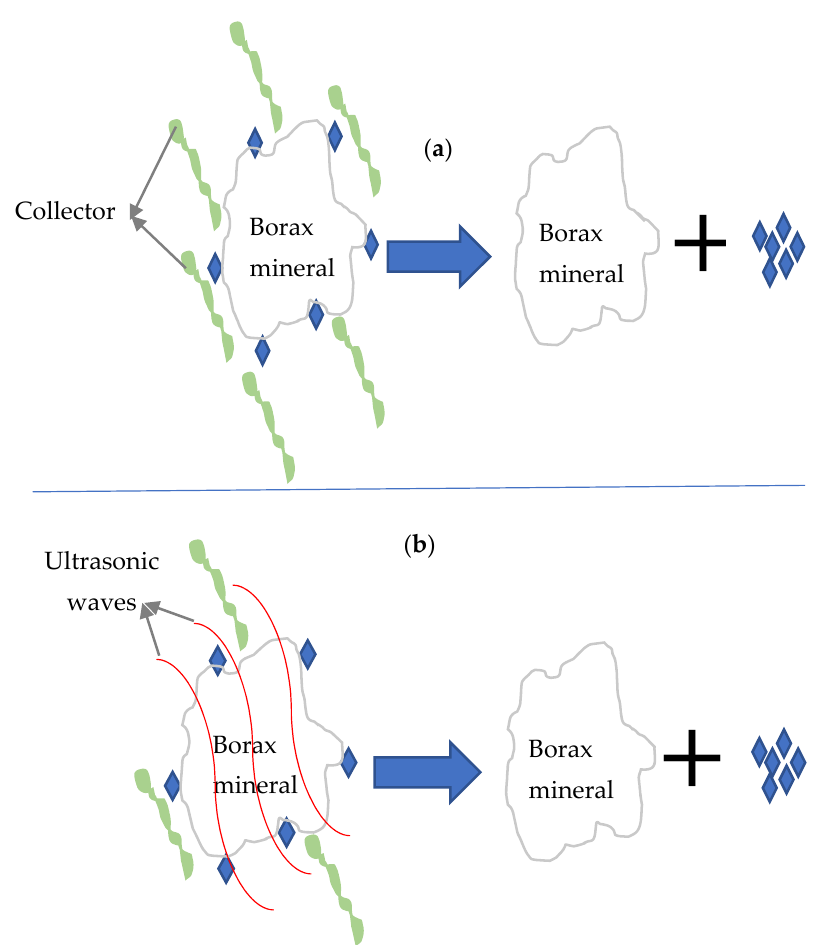
Figure 2. Impact of ultrasonic waves on the flotation of borax mineral: ( a ) clay minerals coated the surface of borax and more collector is needed for beneficiation; ( b ) ultrasonic waves cleaned the surface of borax and lower quantity of collector is required. Table 2. Comparison between ultrasonic beneficiation and mechanical attrition and washing methods